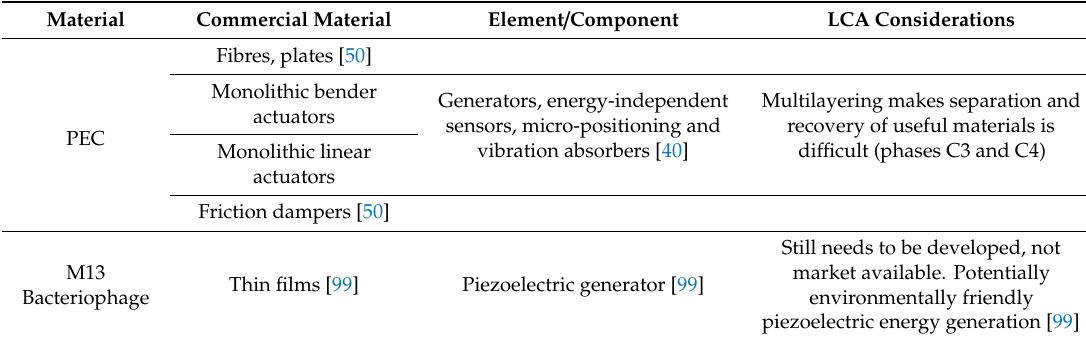
Table 10. Qualitative LCA considerations on